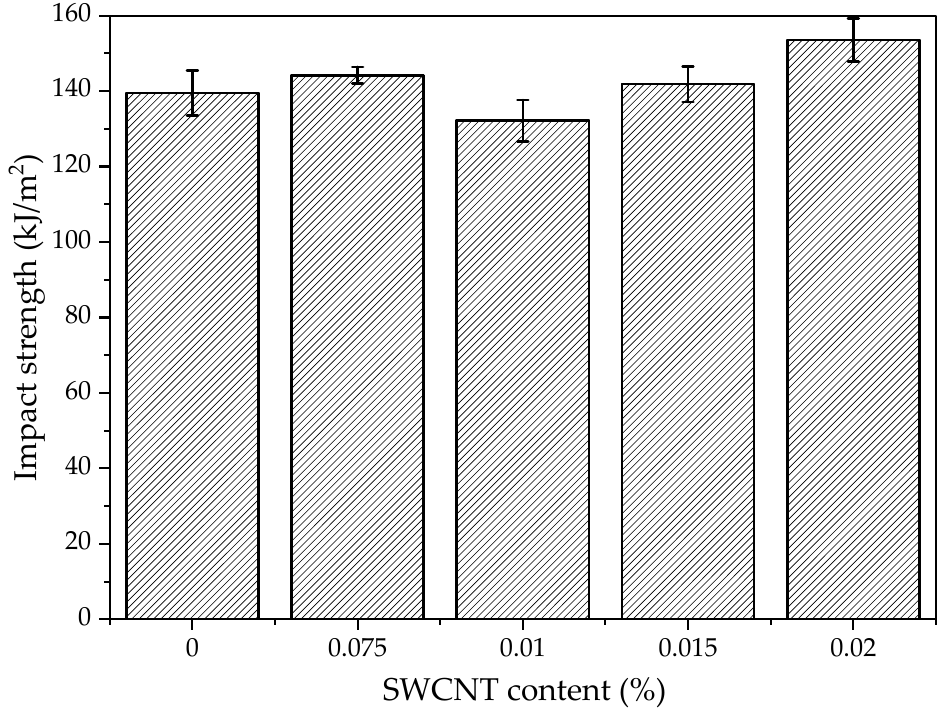
Figure 6. Impact strength of Elium ® resin and Elium ® /SWCNT nanocomposites.